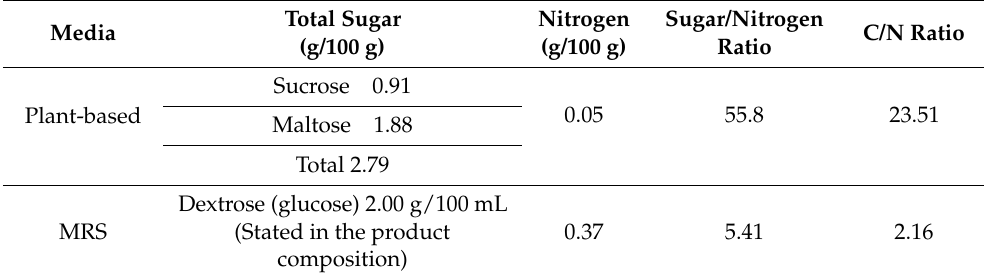
Table 4. Nitrogen and total sugar of